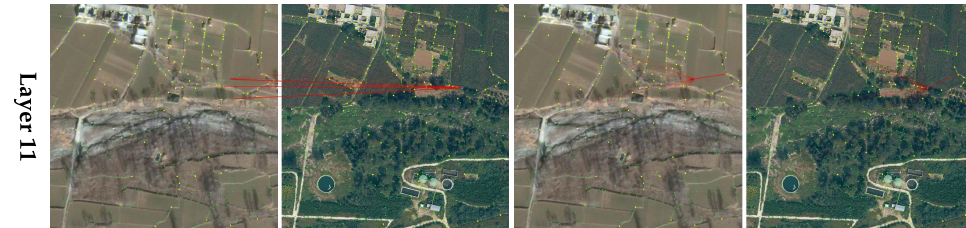
Figure 9. Visualization of the last layer of the Attention for unmatched points. The points to be matched are obtained according to the maximum value of the cross-Attention of the last layer of the unmatched points. The visualization illustrates the distribution of two points on the graph and their Attention.